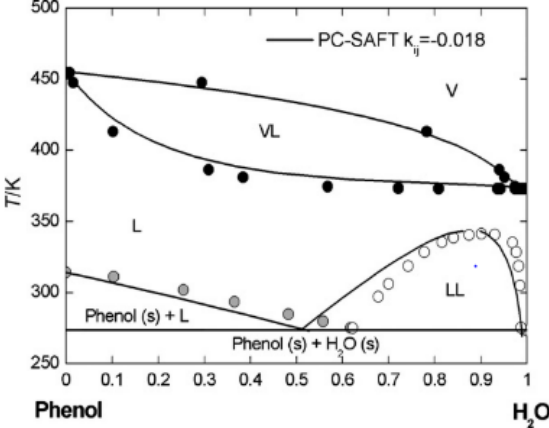
Figure 5. Phase diagram showing vapor-liquid, liquid-liquid, solid-liquid, and solid-liquid-liquid equilibria of phenol-water system. Reproduced from Ref. [26]. Copyright 2007 Elsevier.